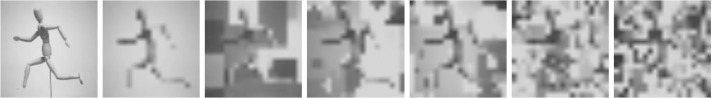
Example images in Clutter Complexity experiment. Images with the running man sculpture as presented in the following seven experimental conditions: from left to right, high-resolution control without background clutter and low-resolution images with 0%, 5%, 10%, 15%, 20%, and 25% background clutter complexity.